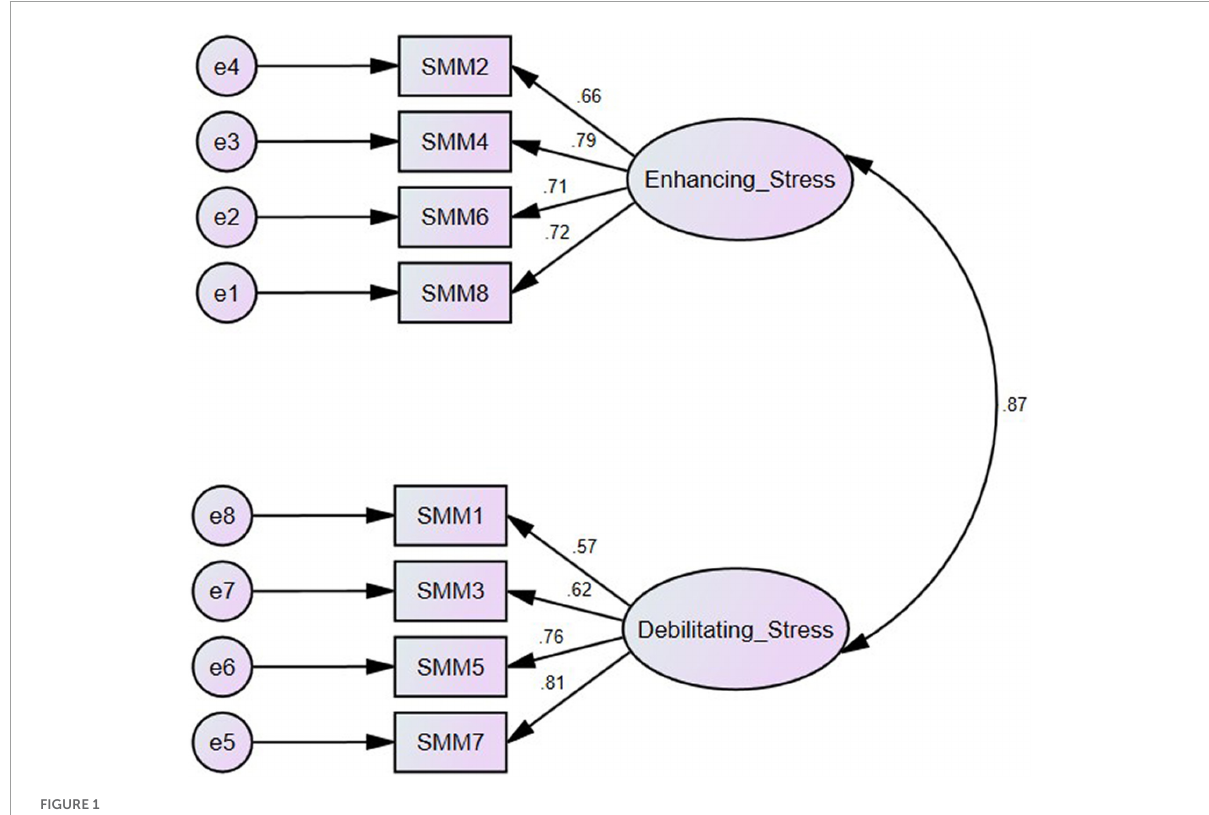
FIGURE1 The two-factor solution model for the Farsi version of the SMM.